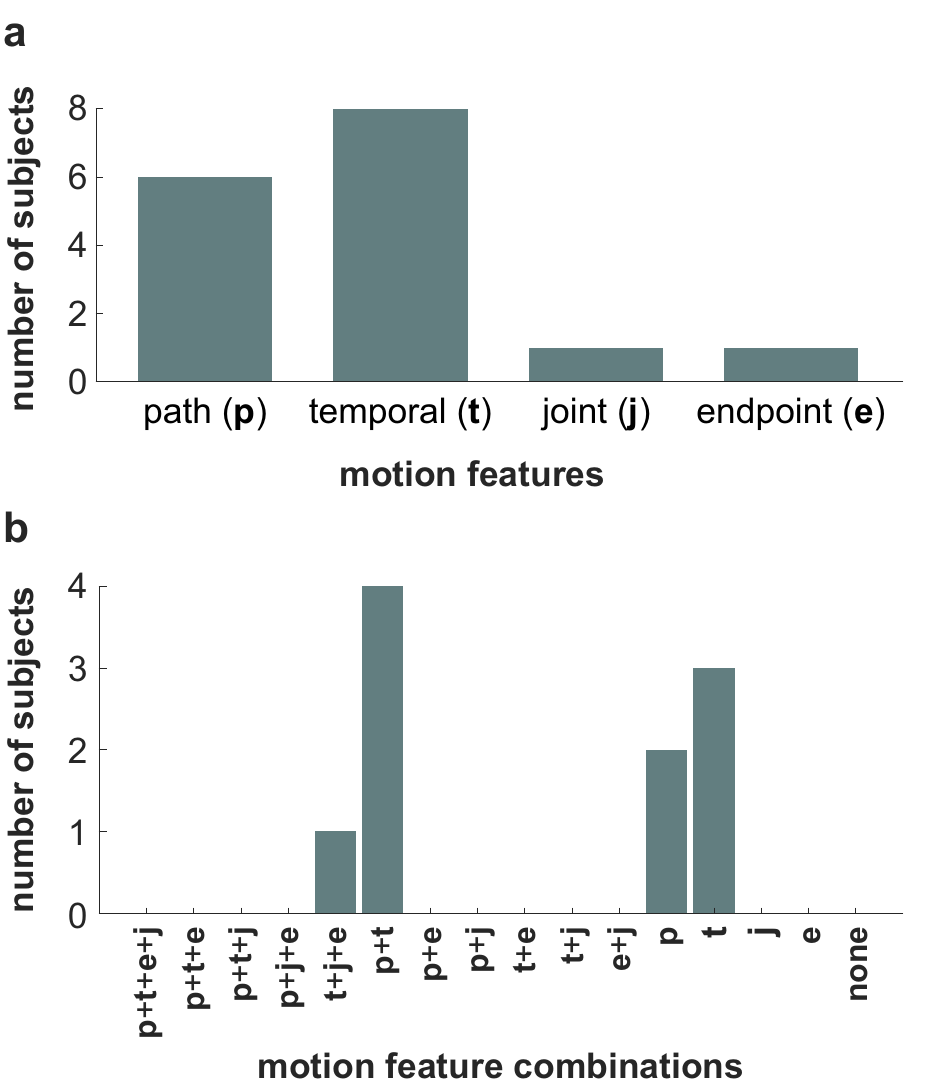
Fig 12. Self-reported strategies in Experiment 2. (a) Histogram of motion features that subjects reported using to estimate stiffness. (b) Histogram of the sixteen possible motion feature combinations that subjects could have reported using to estimate stiffness (p: path information, t: trajectory information, j: joint motion, e: endpoint